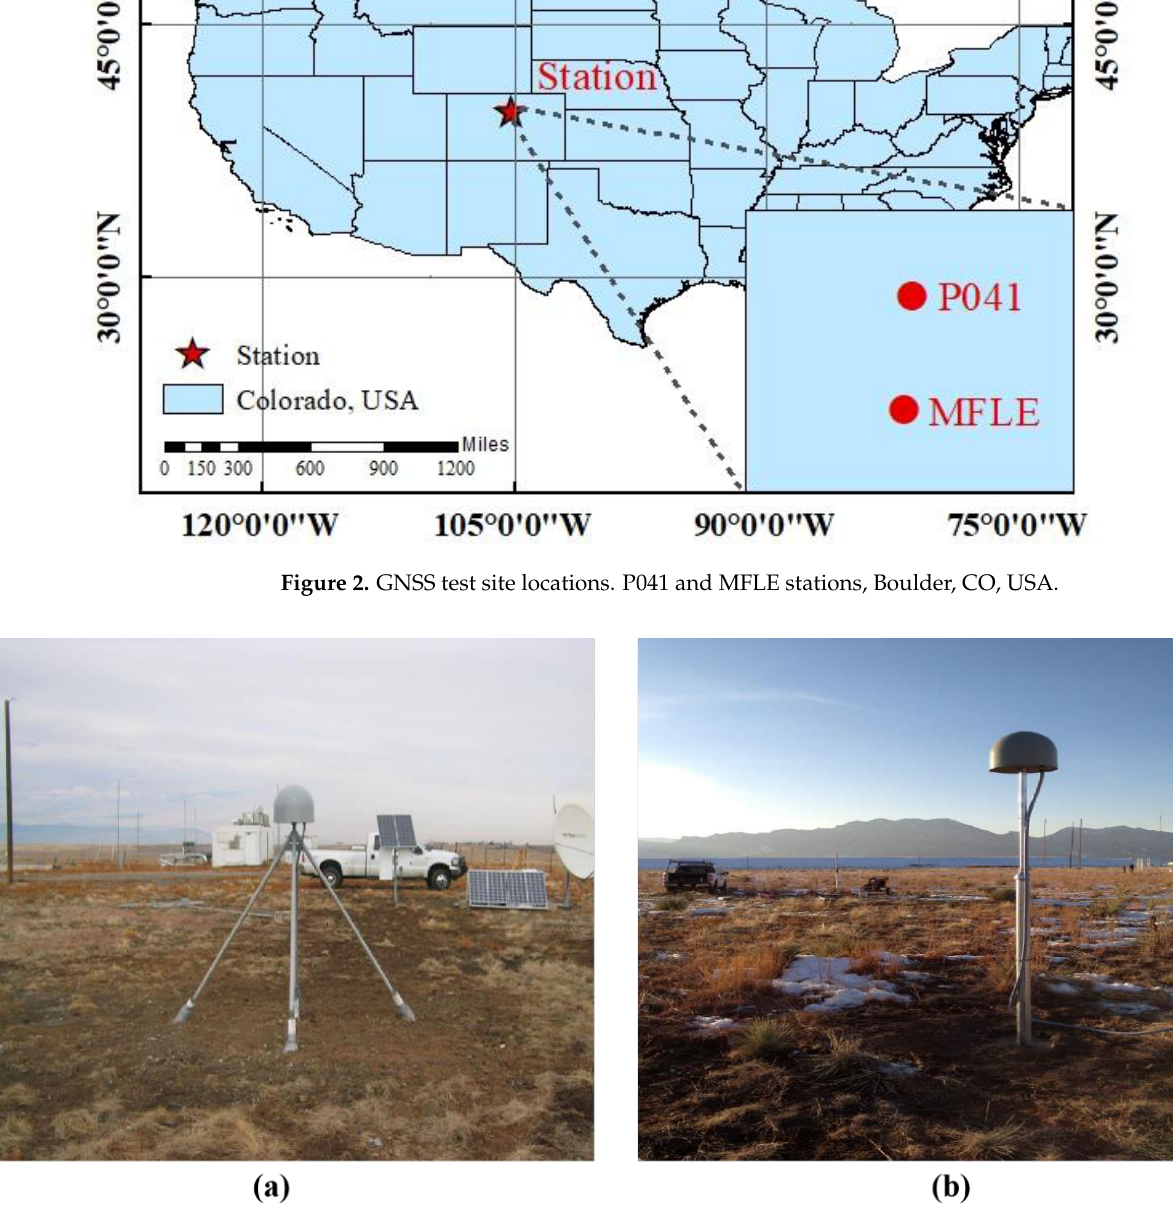
Figure 3. Station conditions: ( a ) Environment around P041 station; ( b ) environment around MFLE station. Note: GNSS test site locations: P041 and MFLE, Boulder, CO, USA (https://www.unavco.org) (accessed on 25 September 2021).